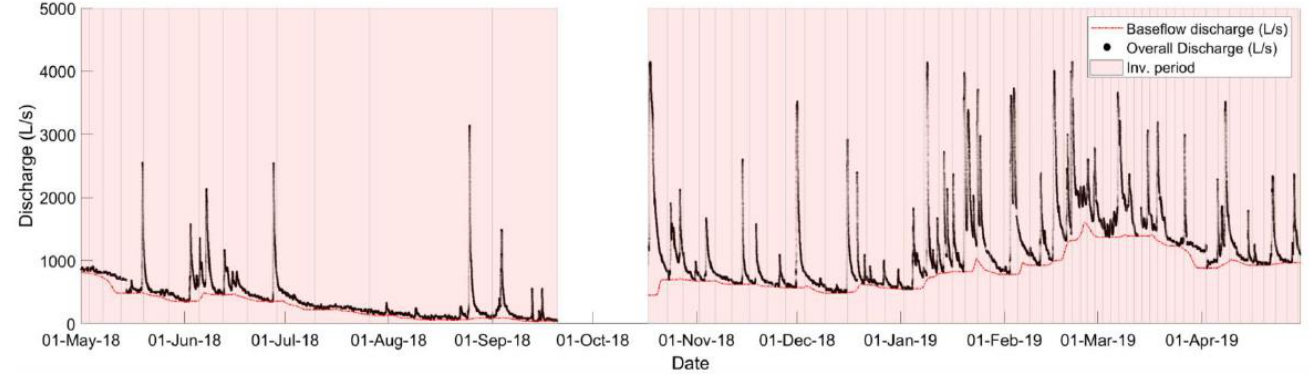
Figure 7. Time periods with a cumulative baseflow volume of 280,000 m 3.